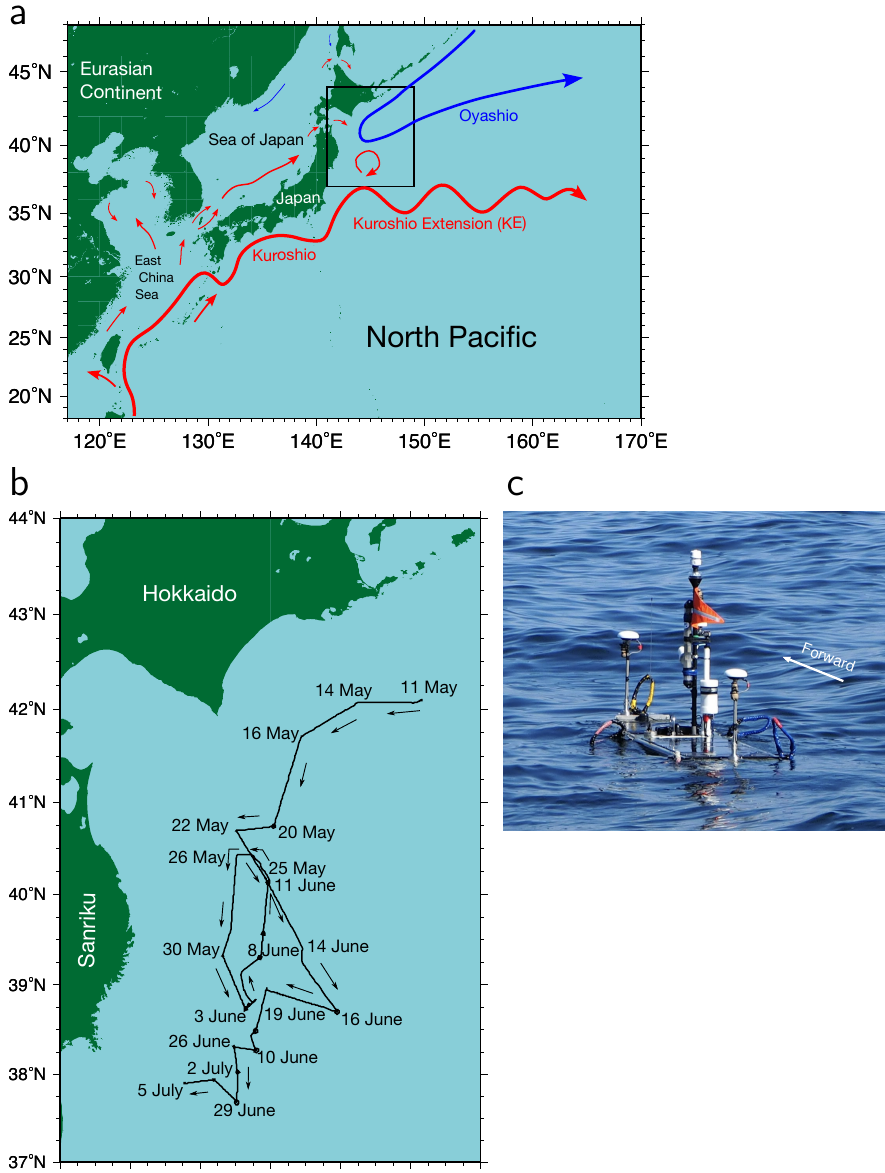
Figure 1. ( a ) Schematic diagram of the subtropical (red arrow lines) and subpolar (blue arrow lines) surface currents in the western North Pacific. The experiment region enclosed by the square is depicted by the enlarged map in panel ( b ). ( b ) Wave Glider (WG) track (black line) and passage dates. The directions of the WG are illustrated by arrows. ( c ) The observing WG immediately after the deployment on 11 May